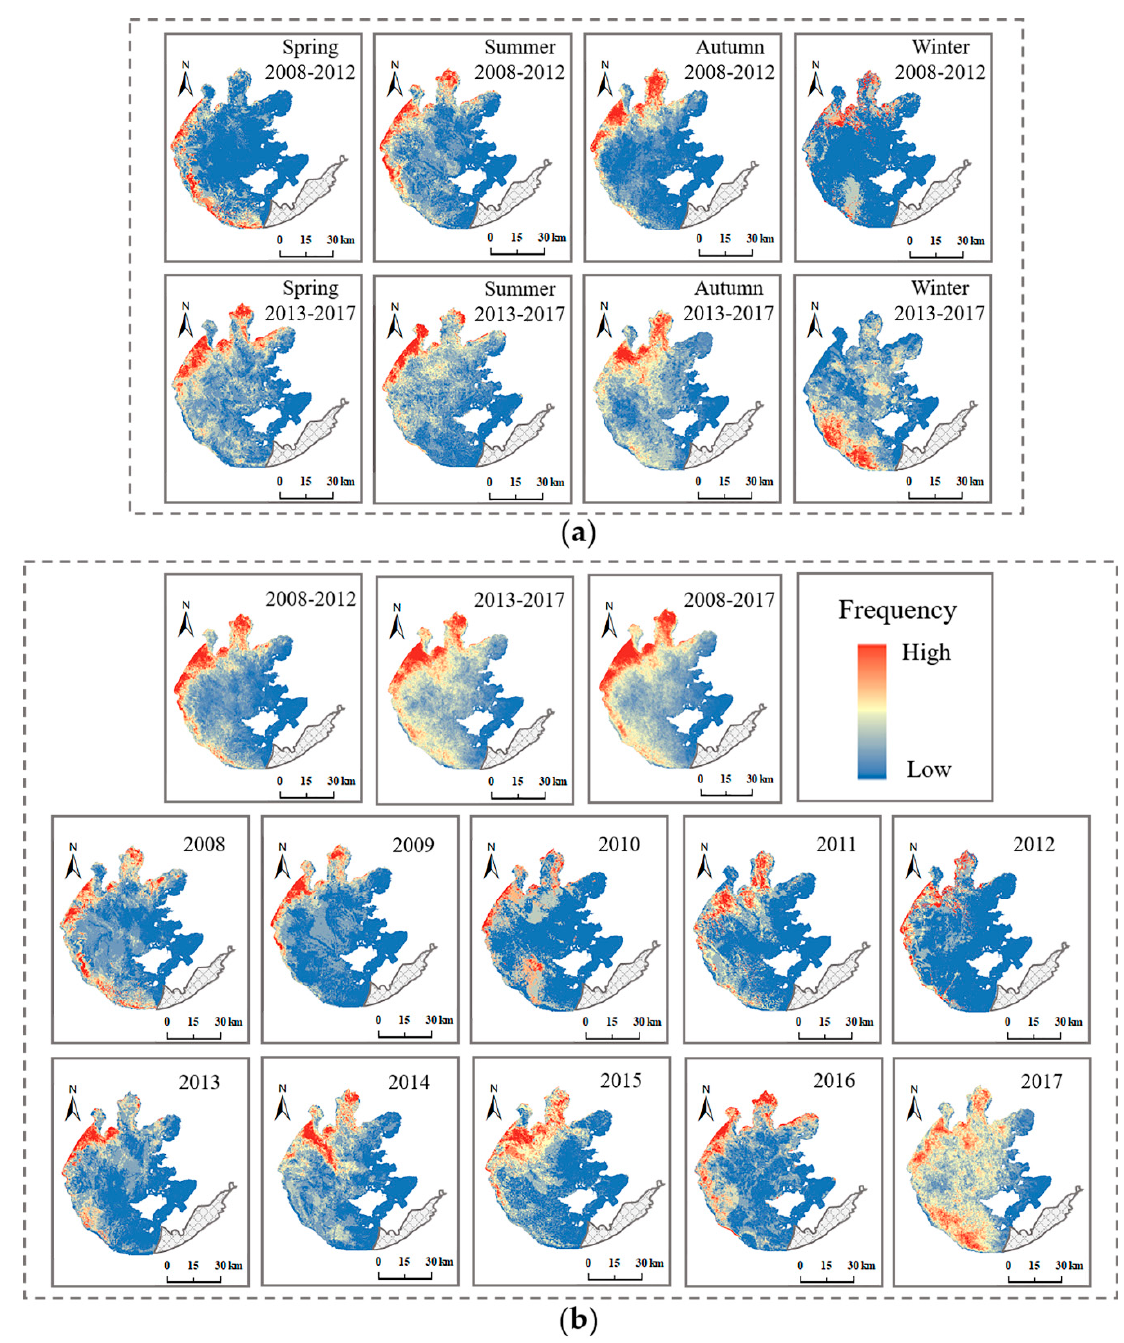
Figure 10. Spatial distribution of the outbreak frequency of algal blooms in Taihu Lake. ( a ) Spatial distribution of the algal bloom frequency in each season. ( b ) Spatial distribution of the bloom frequency in different years.